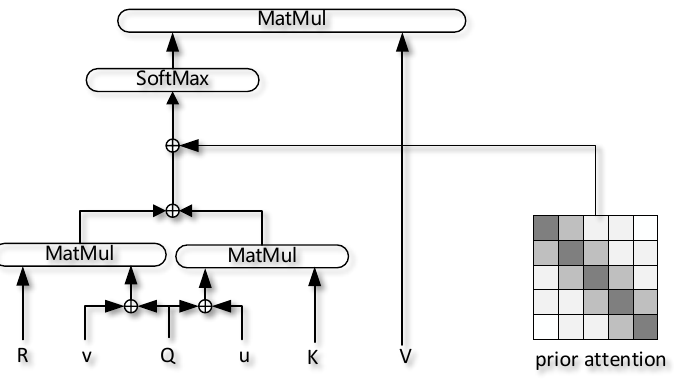
Figure 4. The structure of the local attention layer.